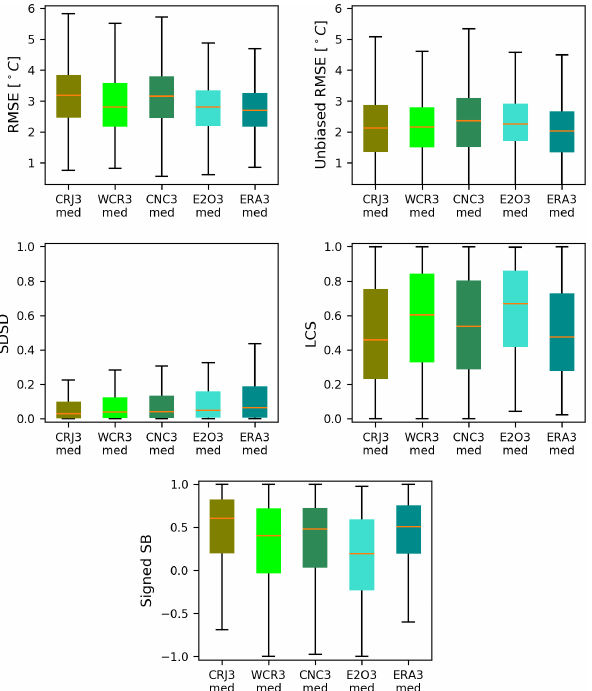
Figure 5. LSWT errors obtained on the 979 lakes observed in GloboLakes for the five simulations CRJRA3med, WCR3med, CNC3med, E2O3med and ERA3med. RMSE, unbiased RMSE, LCS, SDSD and sign SB are represented in boxplots. Median val- ues are represented by orange lines, and quartiles by the edges of the color box.